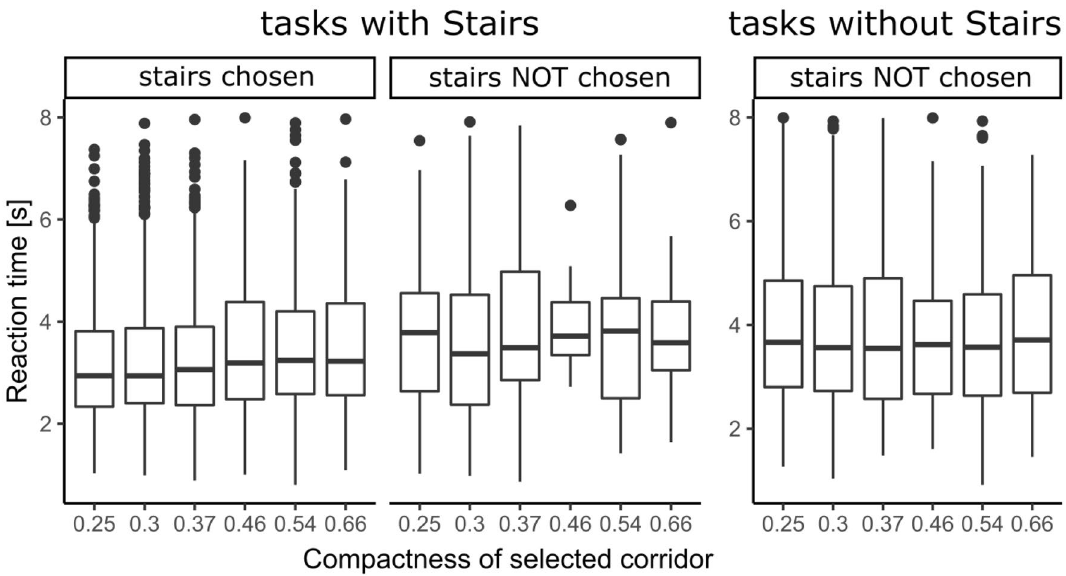
Figure 5. Distribution of respondents’ reaction times grouped by task type, presence of stairs and compactness (box corresponds to the interquartile range with a marked median, whiskers are computed as largest